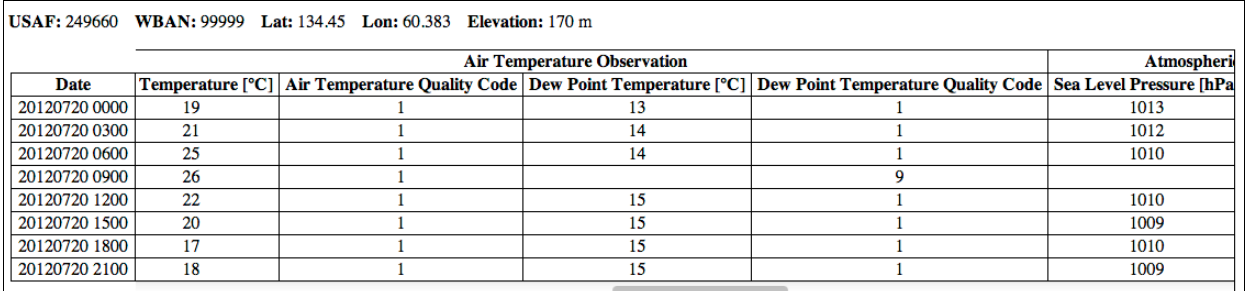
Figure 12. HTML preview of the retrieved data from Integrated Surface Database of the selected station, Ust-Maja (near Yakutsk), for the 20 July